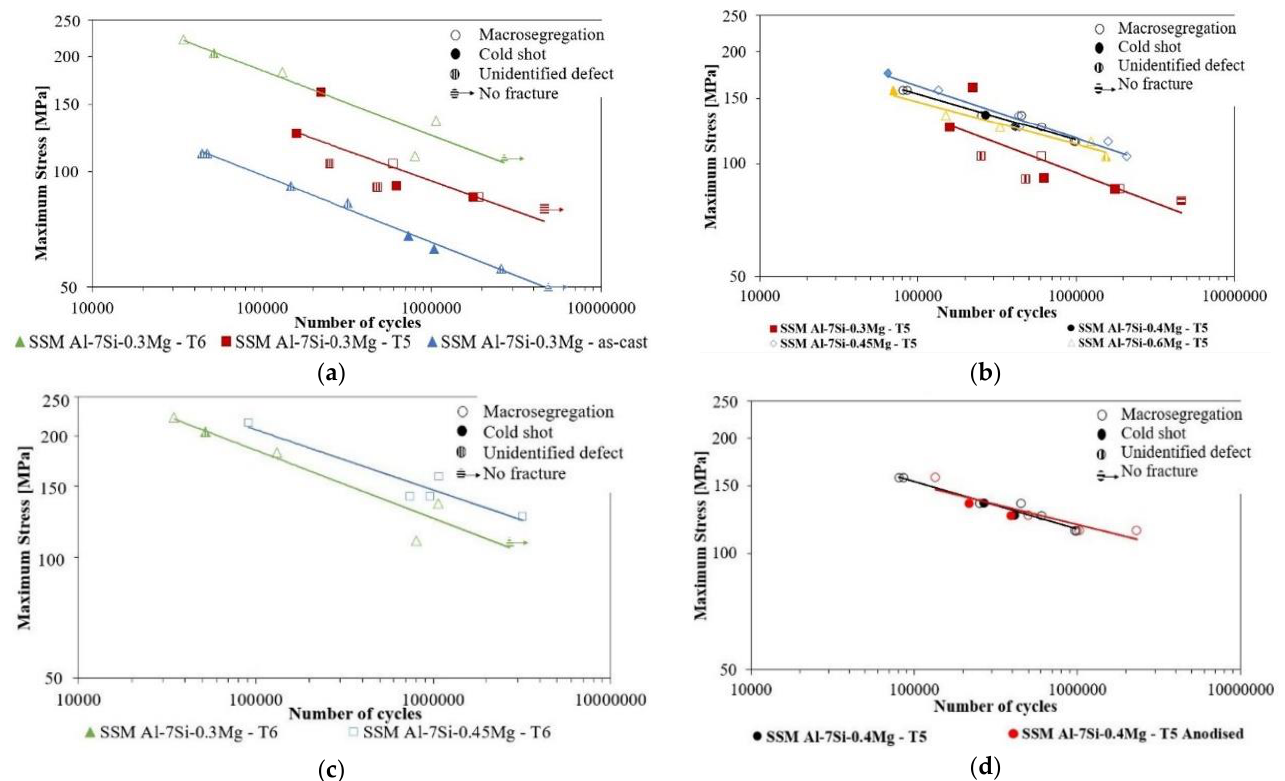
Figure 6. SN curves with all experiments shown and the cause of failure identified on individual sample level of ( a ) SSM Al – 7Si – 0.3Mg castings in the as-cast, T5, and T6 conditions and SSM Al – 7Si – Mg castings with varying magnesium contents in the ( b ) T5 and ( c ) T6 conditions. ( d ) SN